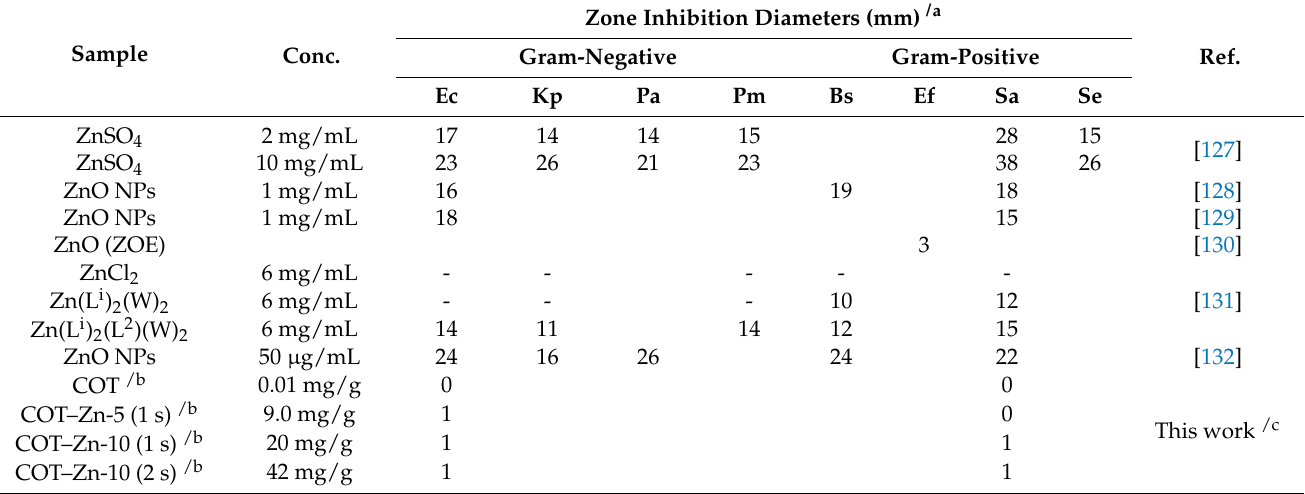
Figure 6. Tests of antimicrobial activity of COT–Zn (0) composites against S. aureus. Inhibition zones of bacterial growth in Petri dishes: ( a ) COT; ( b ) COT–Zn-10 (1 s/2 s). A comparison of these results (ZID) with representative data from the literature is given in Table 5. Table 5. Results of antibacterial activity test of zinc compounds and composites.